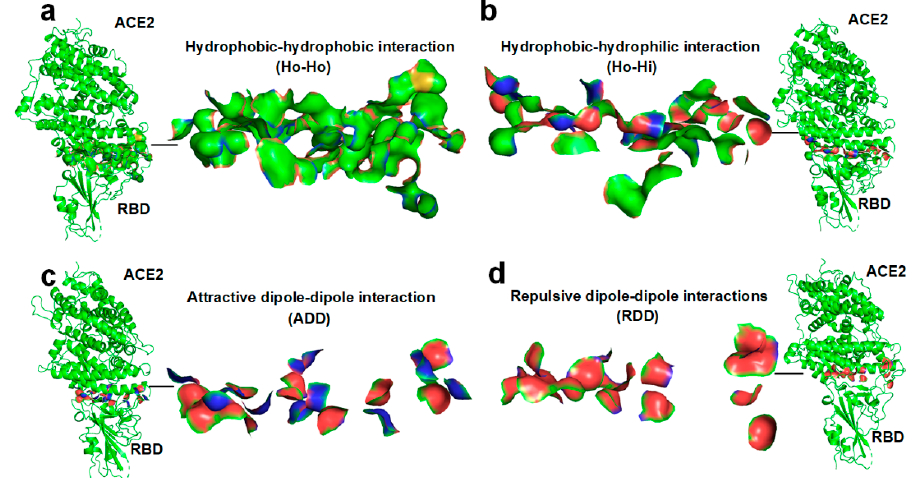
Figure 1. Four types of surface interactions between SARS-CoV-2 S RBD and ACE2 at the interface of the complex. ( a ) The hydrophobic–hydrophobic (Ho-Ho) interactions at the RBD–ACE2 complex interface. ( b ) The hydrophobic–hydrophilic (Ho-Hi) interactions at the RBD–ACE2 complex interface. ( c ) The attractive dipole–dipole (ADD) interactions at the interface of the RBD–ACE2 complex. ( d ) The repulsive dipole–dipole (RDD) interactions at the interface of the RBD–ACE2 complex. The hydrophobic surface areas are highlighted in green and yellow, the hydrophilic surface areas are highlighted in red and